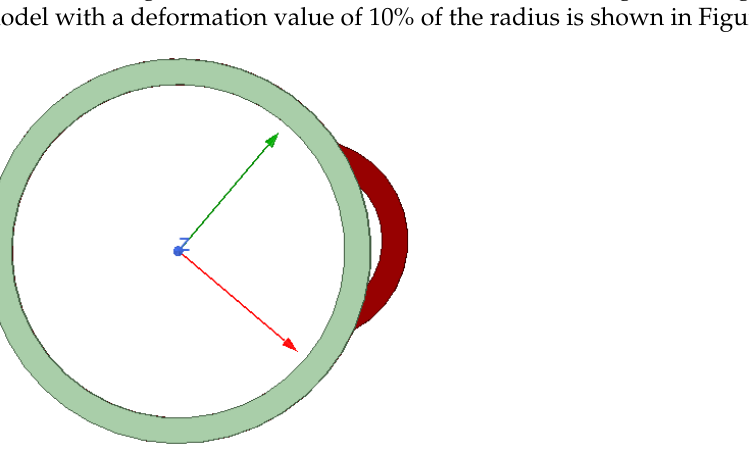
Figure 7. Top view of the high-voltage winding model with a deformation of 10% of the radius.